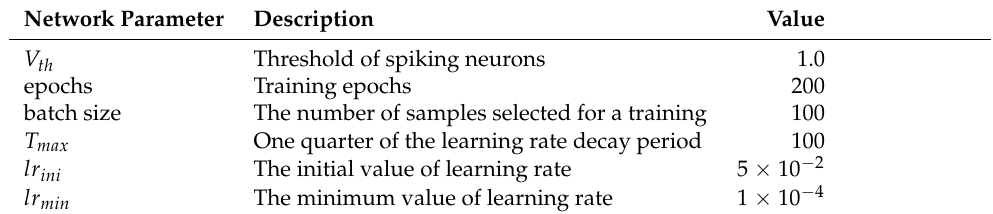
Table 5. Parameters set of Mnist and Fashionmnist dataset.